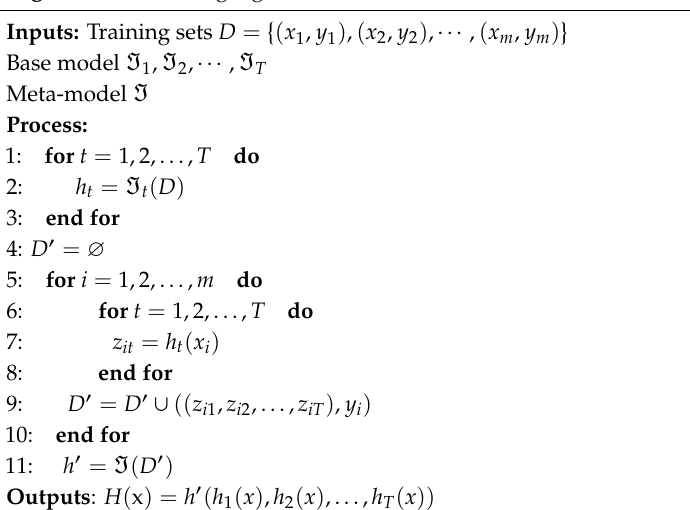
Algorithm 1. Stacking